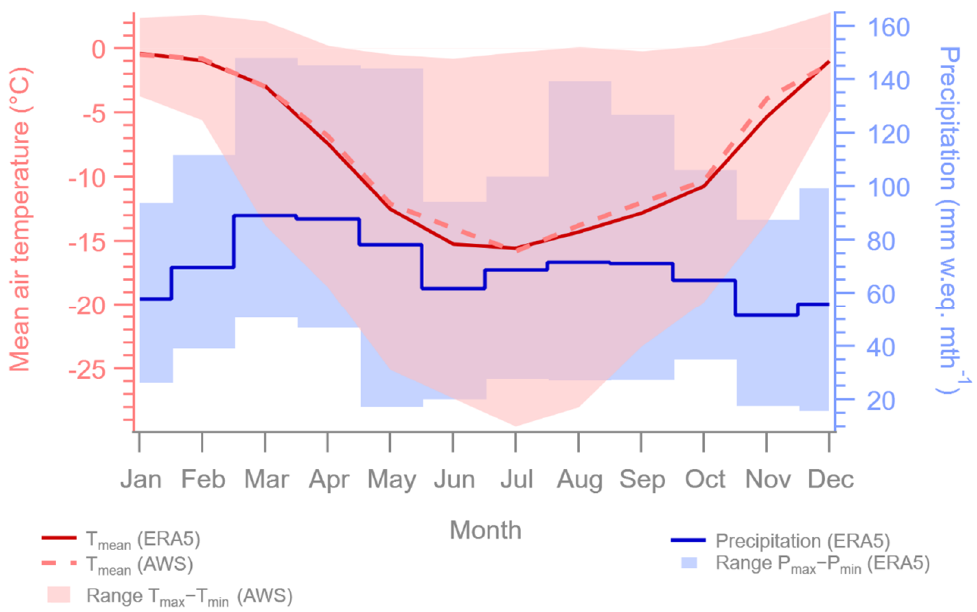
Figure 3. Seasonal variability of monthly mean 2-m air temperature (red) and precipitation (blue, in millimeter water equivalent per month) at Young Island derived from an automatic weather station (AWS) in 1991–1994 and 1996–1997 and ERA5 reanalysis 1979–2020; figure adapted from [35].